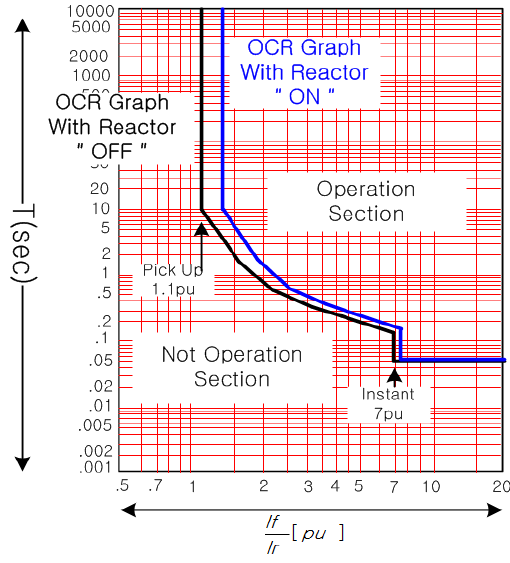
Figure 4. Example of re-coordination of overcurrent relay (OCR) due to installing the reactor.